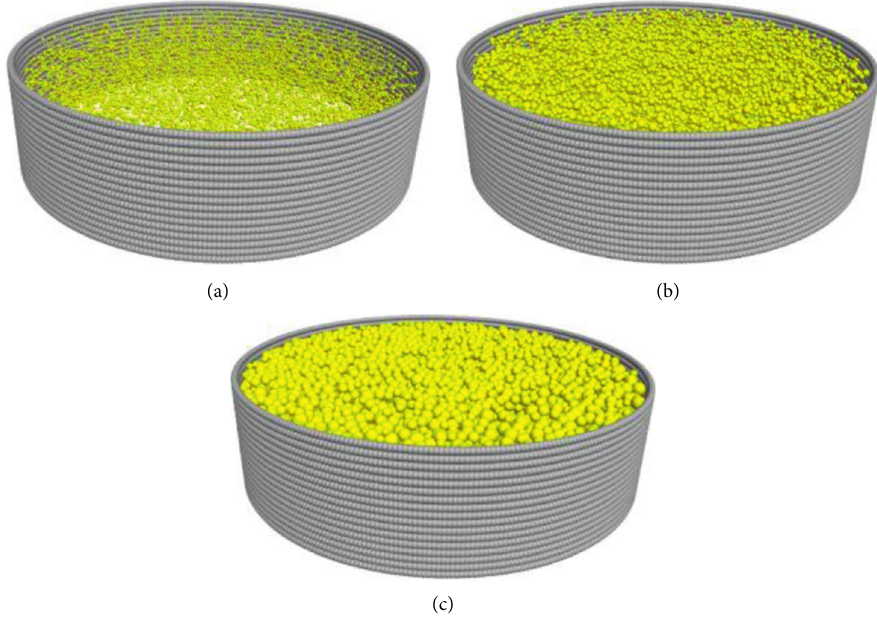
Figure 6: Particle generation. (a) Balls with 1/5 target diameter. (b) Balls with 3/5 target diameter. (c) Balls with target diameter.